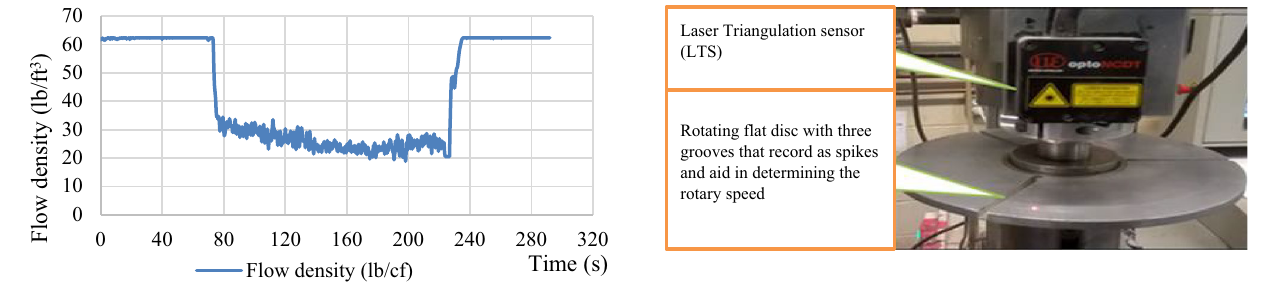
Fig. 14 Effects of gas kick on mud density of the return fluid for